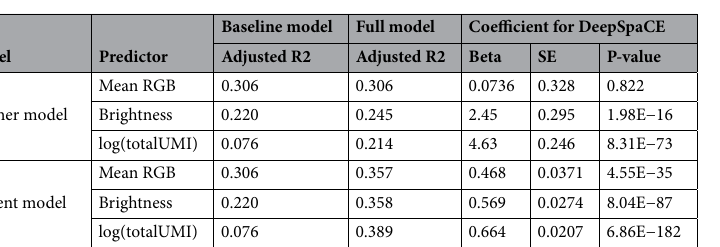
Figure 4. Semi-supervised learning for the tissue section imputation. ( a ) Box plots show Pearson’s correlation coefficients between the measured and predicted gene-expression levels of 21 breast cancer-related microenvironment markers. Left box plot displays the results of semi-supervised learning, which showed increasing Pearson’s correlation coefficients. Middle and right box plots show the semi-supervised learning results with permutated and randomized values. For the box plot, the box indicates the first and third quartiles; horizontal center line marks the medians; upper whisker extends from the hinge to the highest value that is within 1.5× interquartile range (IQR) of the hinge; lower whisker extends from the hinge to the lowest value within 1.5× IQR of the hinge; and data were plotted as points. Black lines between boxes connect the same gene. ( b ) Box plots show Pearson’s correlation coefficients between the measured and predicted gene-expression levels of 21 breast cancer-related microenvironment markers. Three types of image sets were compared for semi-supervised learning, namely sections A–C (red); data from The Cancer Genome Atlas (TCGA) (blue); and ImageNet data (green). For the box plot, the box indicates the first and third quartiles; horizontal center line marks the medians; upper whisker extends from the hinge to the highest value that is within 1.5× IQR of the hinge; lower whisker extends from the hinge to the lowest value within 1.5× IQR of the hinge; and data were plotted as points.